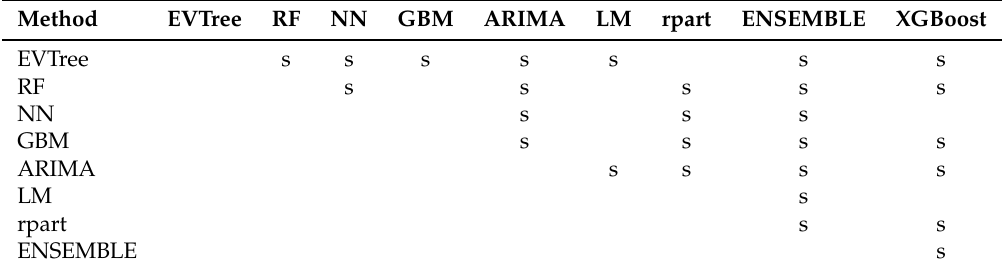
Table 7. Significance of the results regarding RMSE according to two-tailed t -test with confidence level of 1%. Method